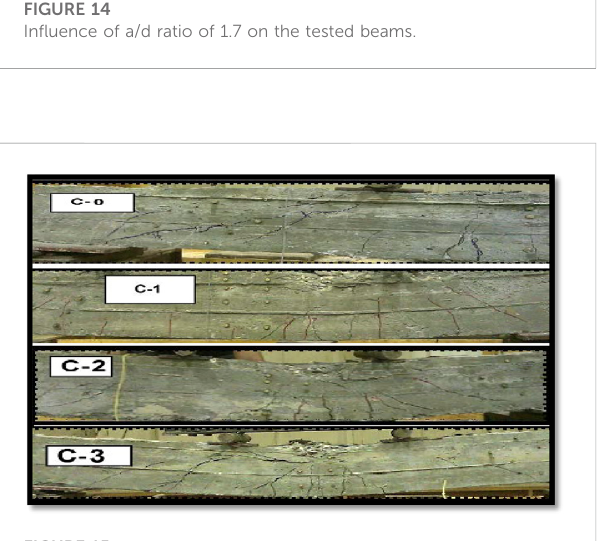
FIGURE 15 In fl uence of a/d ratio of 2.2 on the tested